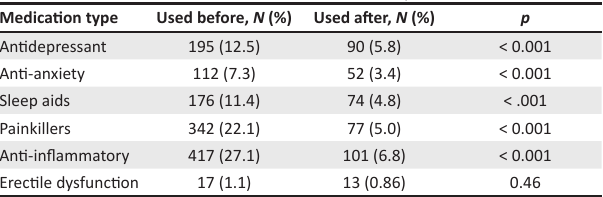
TABLE 8: Energy and activity, physical and emotional well-being before and after low-carbohydrate diet initiation.